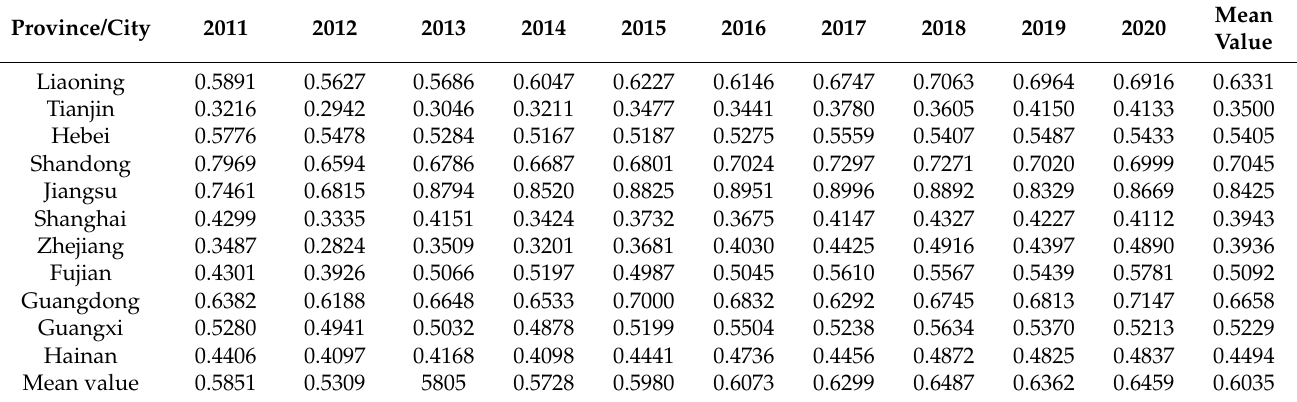
Table 4. Marine-environment quality level in China’s coastal provinces/cities (2011–2020).